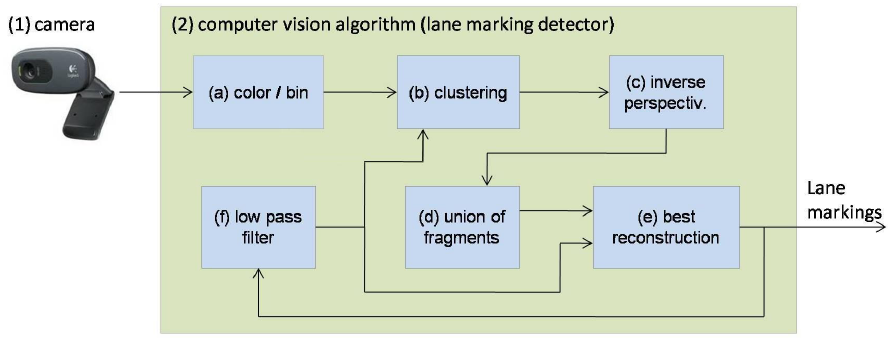
Figure 6. Components of the lane marking sensor: (1) The camera. (2) The computer vision algorithm for lane markings